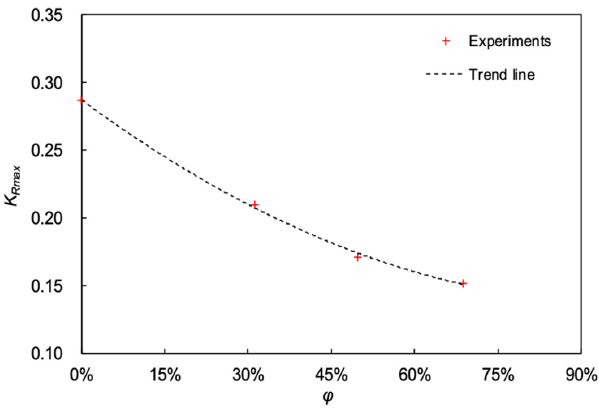
Figure 9. Variation of Bragg resonant reflection coefficient peak K Rmax with permeability ϕ .